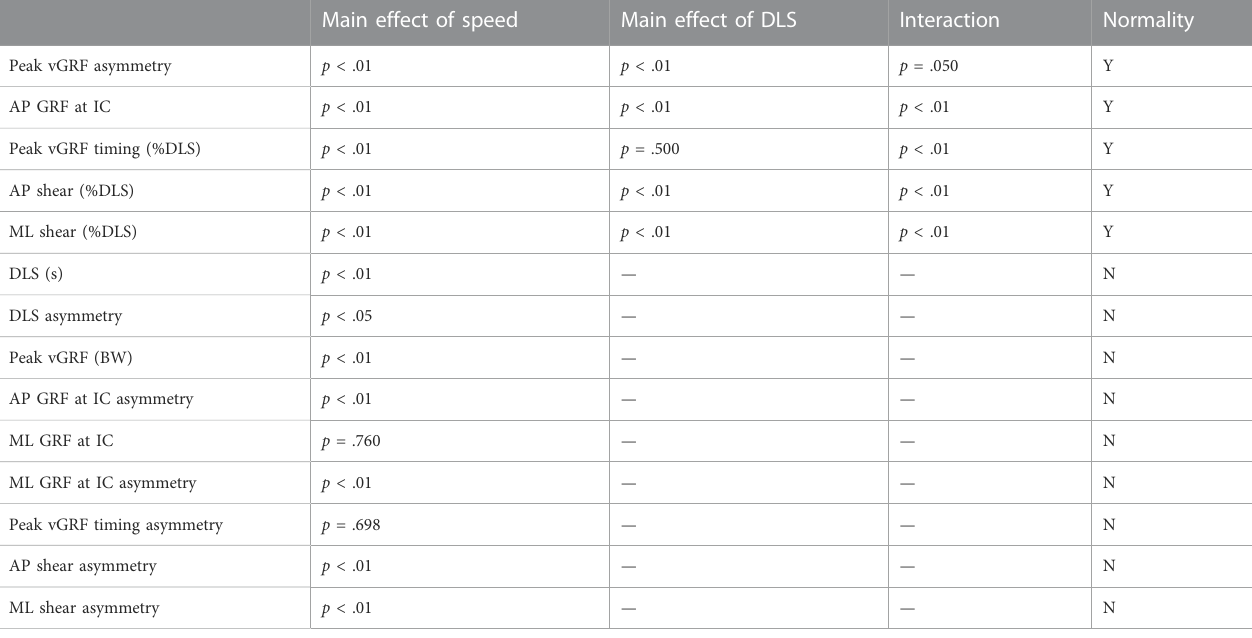
TABLE 2 Main effects of speed and DLS by statistical tests for gait parameters and asymmetry